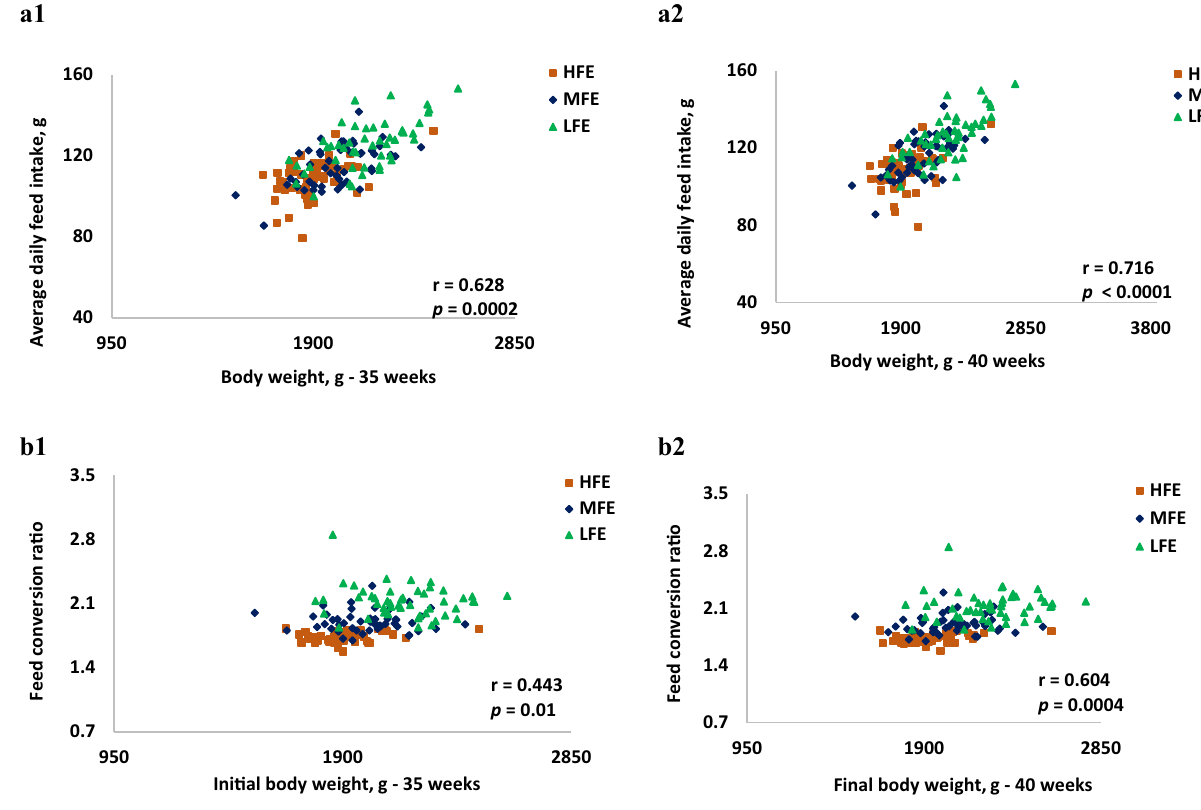
Figure 1. Correlation of average daily feed intake and bodyweights at 35 and 40 weeks old ( a1 and a2 ) and feed conversion ratio and body weights at 35 and 40 weeks old ( b1 and b2 ), of individually housed ISA brown